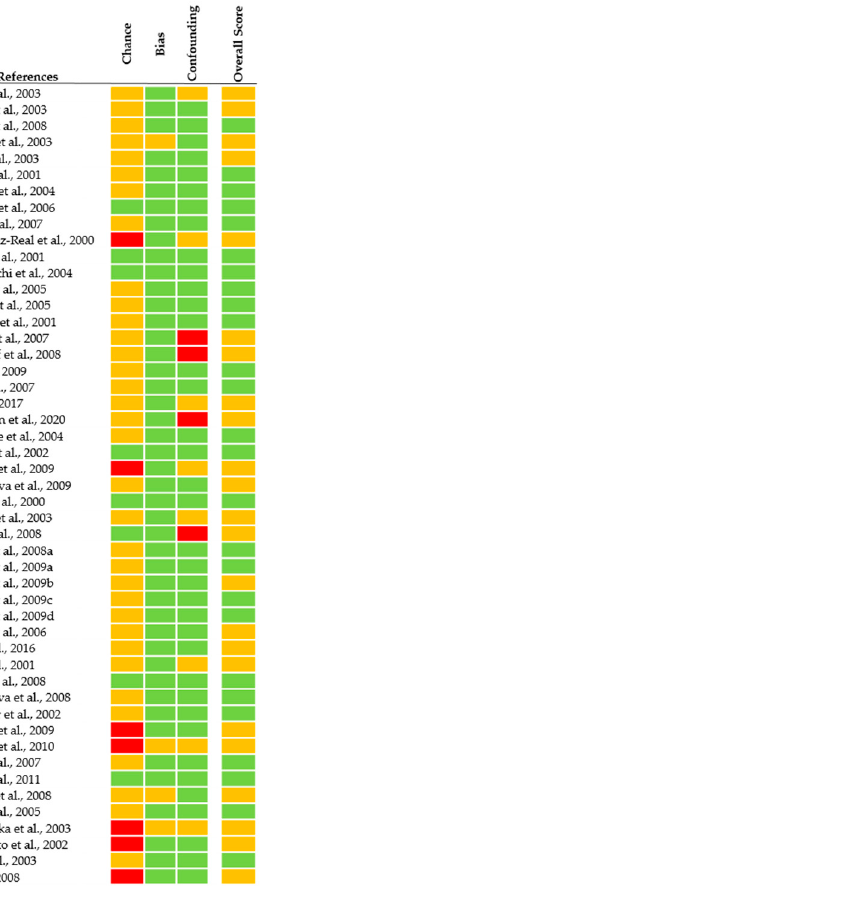
Figure 2. Quality assessment of genetic association studies [11]. The quality ratio was rather high (green), intermediate (yellow), or low (red). Abate et al. 2003 [49]; Baratta et al. 2003 [37]; Baratta et